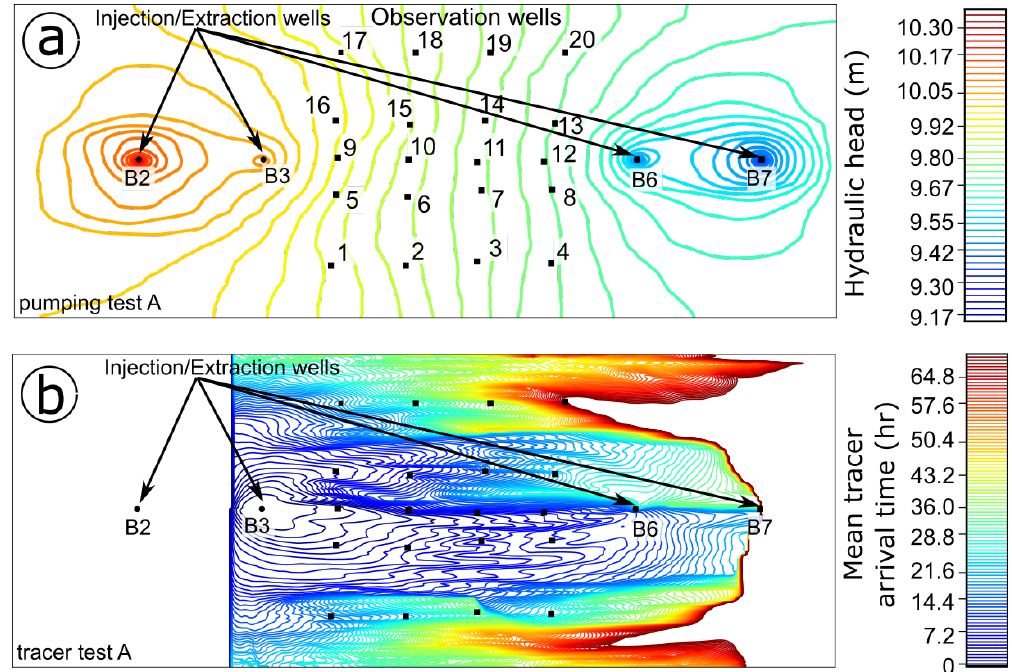
Figure 5. Steady-state hydraulic head field ( a ) and mean tracer arrival times ( b ) for pumping and tracer test A. Black circles: injection/extraction wells. Black squares: observation